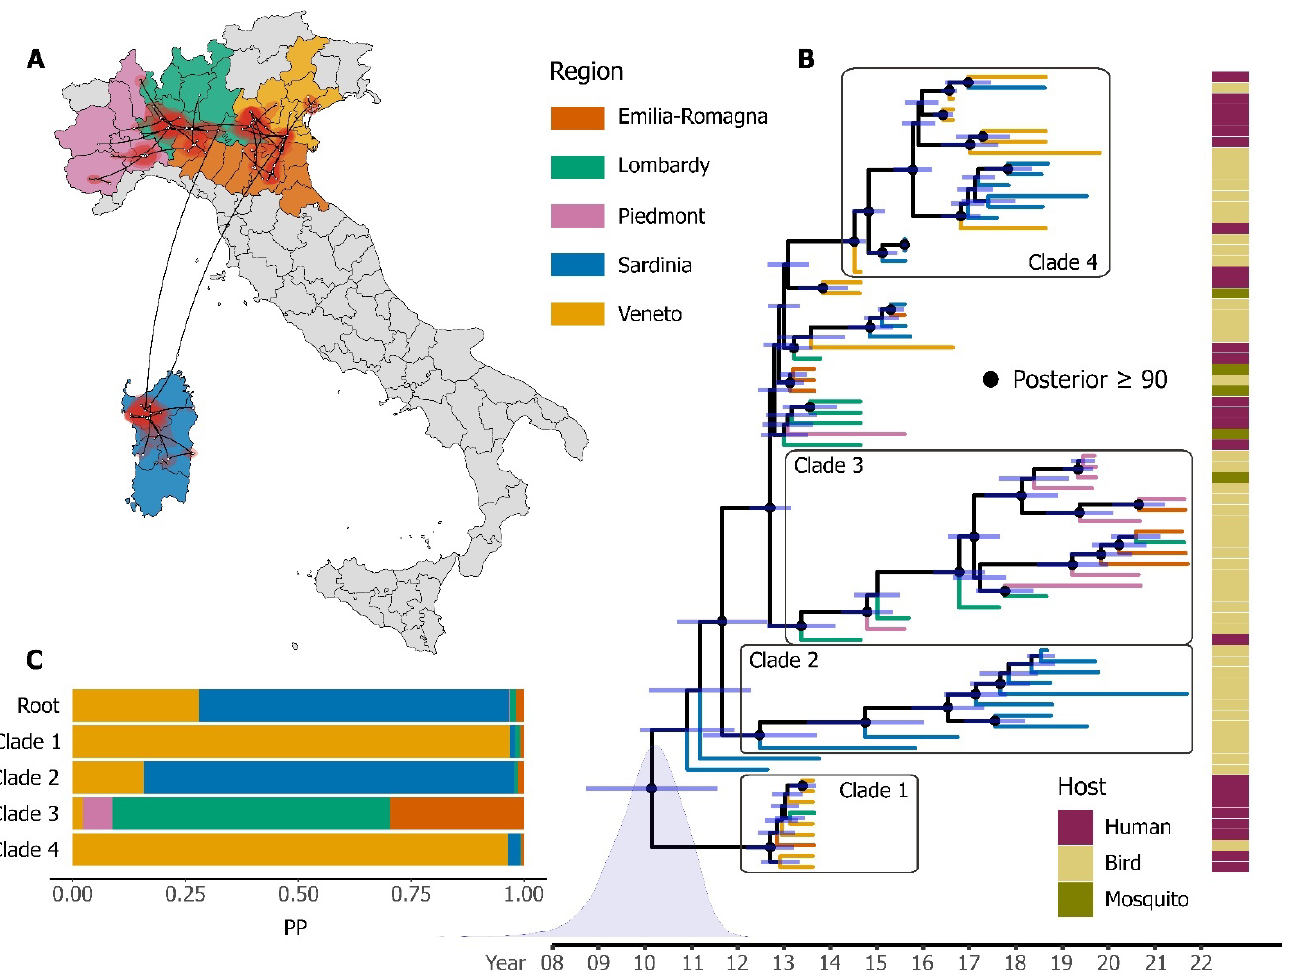
Figure 4. Phylogeographic analysis of WNV L2 sequences, part of the identified Italian clade. Colours indicate samples originating from five different Italian regions where the virus was detected. ( A ) The geographic position and the connection between all genomes analysed are shown. ( B ) Uncertain dates are represented with light blue bars showing the 95% HPDs. Nodes with high posterior probabilities (≥90) are indicated with black dots. The host from which the sample was reconstructed is indicated in a column on the right with bars of different colours. The blue curve at the root represents the posterior density. ( C ) A table showing posterior probabilities for the location state of the root and the four highly supported clades.